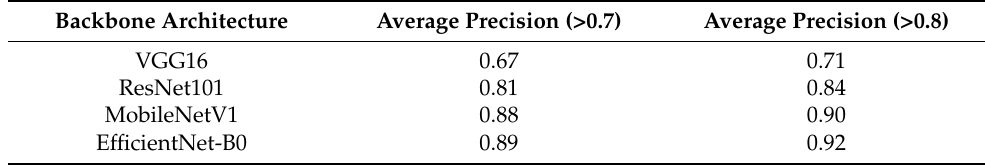
Table 5. Average precision parameter comparison of rice grade with various backbone